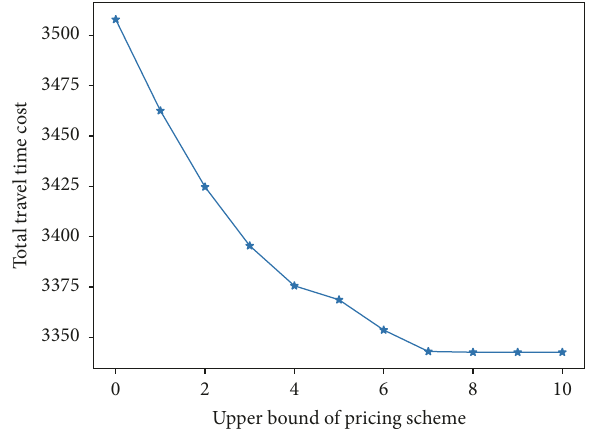
Figure 7: Variance of total travel-time cost with respect to the upper bound of congestion